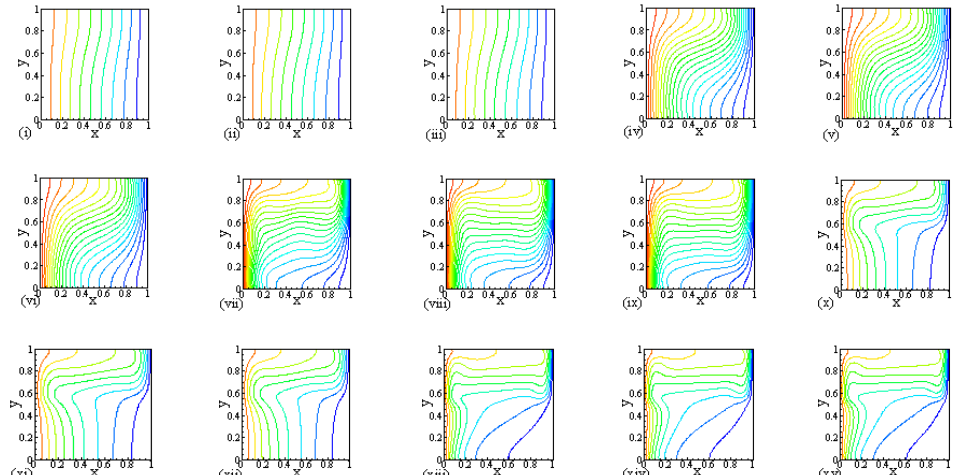
Fig. 5 (a). Isotherms of horizontal porous layer at (i)  =0.4 (ii)  =0.6 (iii)  =0.9 while Ra = 10 3 , Da = 10 -2 , (iv)  =0.4 (v)  =0.6 (vi)  =0.9 while Ra = 10 4 , Da = 10 -2 , (vii)  =0.4 (viii)  =0.6 (ix)  =0.9 while Ra = 10 5 , Da = 10 -2 , (x)  =0.4 (xi)  =0.6 (xii)  =0.9 while Ra = 10 5 , Da = 10 -4 and (xiii)  =0.4 (xiv)  =0.6 (xv)  =0.9 while Ra = 10 6 , Da = 10 -4